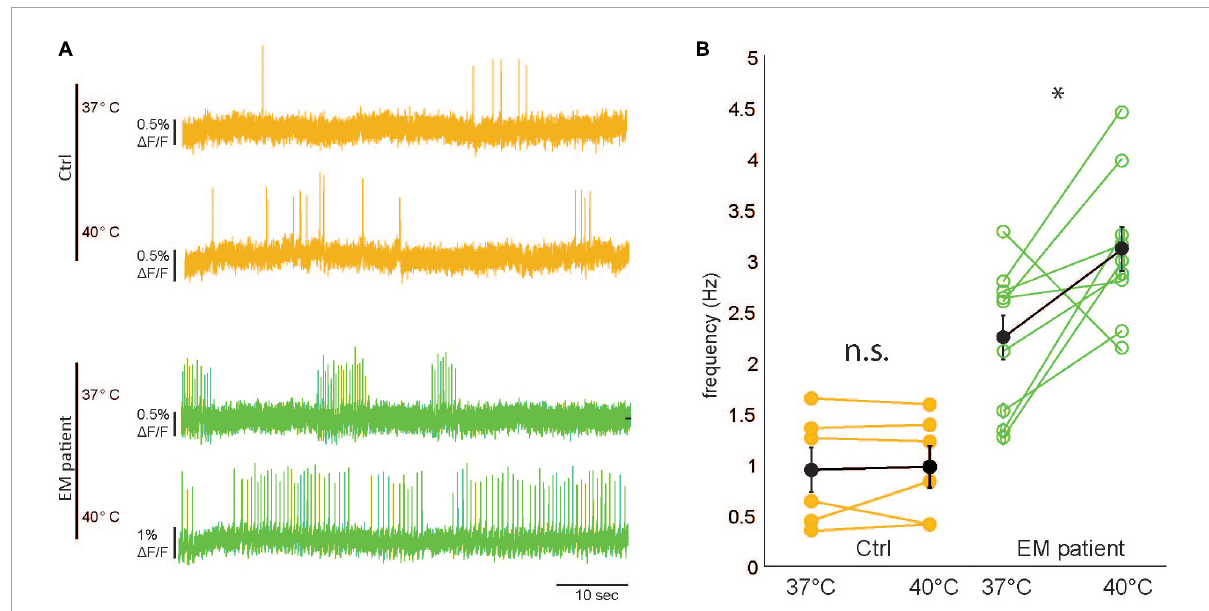
FIGURE4 Erythromelalgia (EM) patient human induced pluripotent stem cell–derived sensory neurons (hiPSC–SNs) are hypersensitive to mild increases in ambient temperature. (A) Representative raw imaging traces of control hiPSC-SNs (top, orange) and EM patient–SNs (bottom, green) at 37 and 40 ◦ C. (B) Comparison of spike frequency filled black dots indicate average values. Error bars indicate SEM. [ EM patientdSNs N = 10, control human induced pluripotent stem cell-derived sensory neurons (hiPSCdSNs) N = 6, Wilcoxon rank-sumtest, control: ∗ p = 0.87, EM patient: ∗ p =